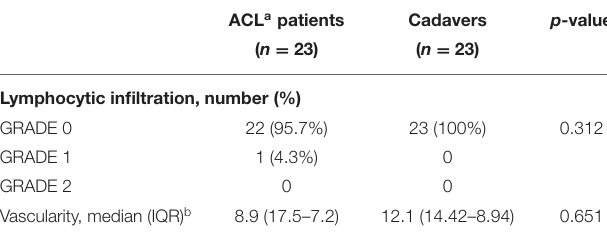
TABLE 1 | IFP histopathological